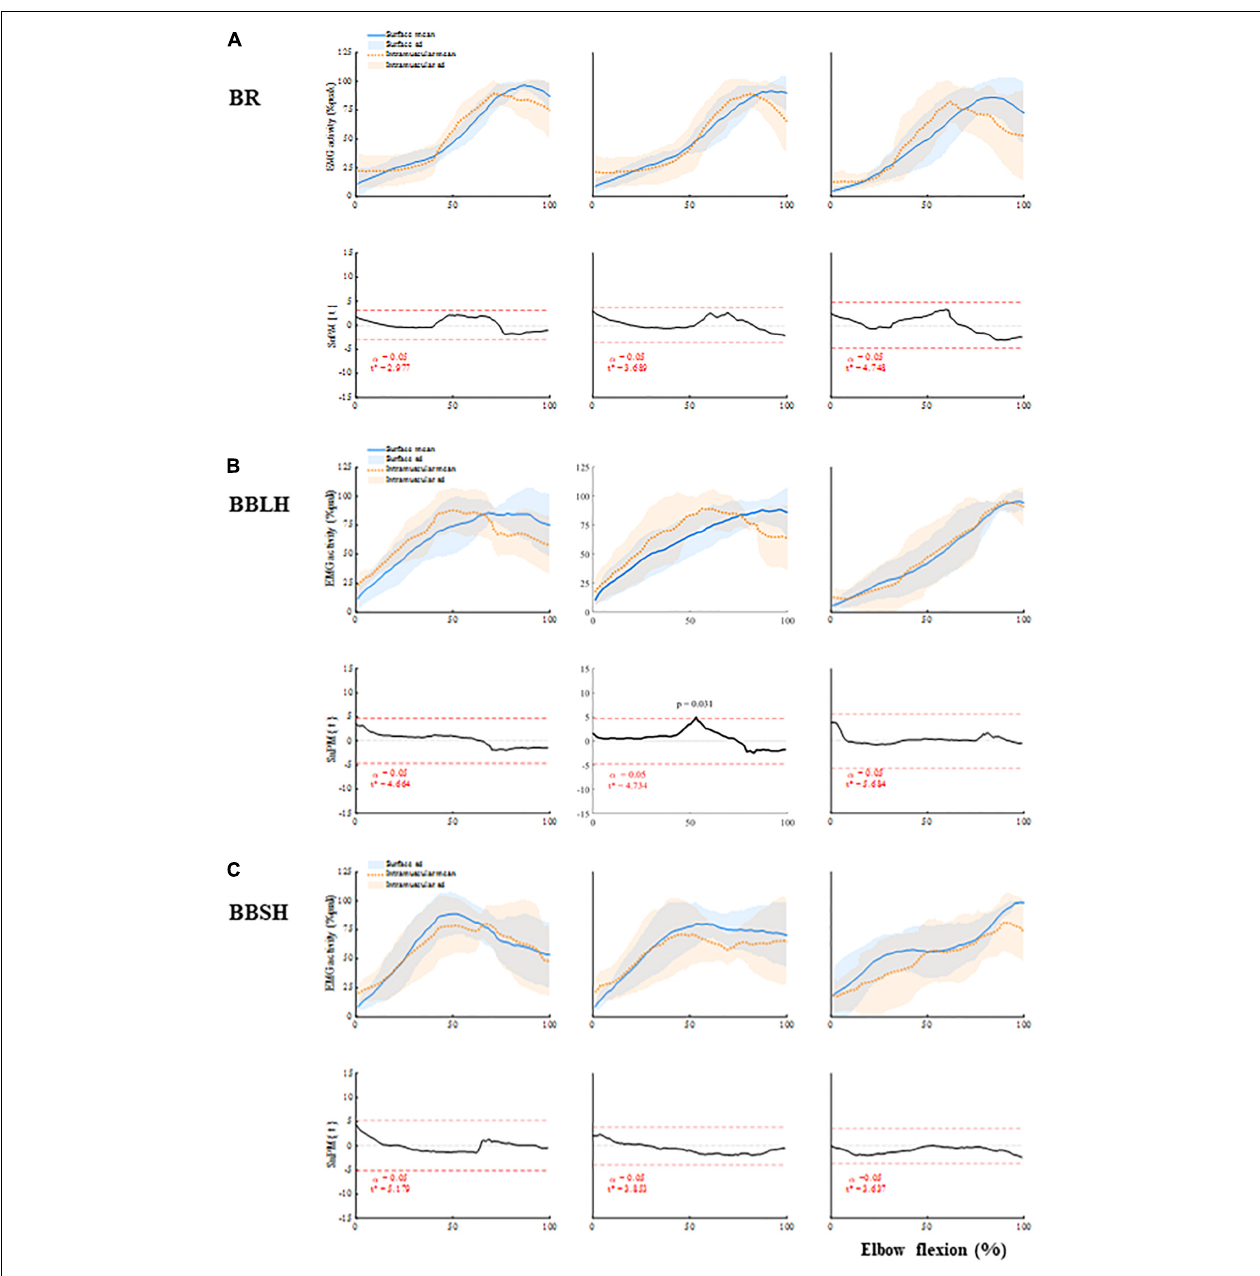
FIGURE 3 | Muscle activity of the elbow flexors and comparisons between the surface and intramuscular EMG (A) BR, (B) BBLH, and (C) BBSH activities, and the comparisons between surface and intramuscular EMG. Upper panels of each muscle represent mean and standard deviation of the muscle activity for each forearm position. Lower panels of each muscle represent the scalar output statistic, SPM{t} (solid black lines), and the critical thresholds (t ∗ ) calculated for α significance level defining supra-threshold clusters for SPM{t} trajectories (dashed red lines). BBLH, long head of the biceps brachii muscle; BBSH, short head of the biceps brachii muscle; BR, brachialis muscle; EMG, electromyography; SPM, statistical parametric